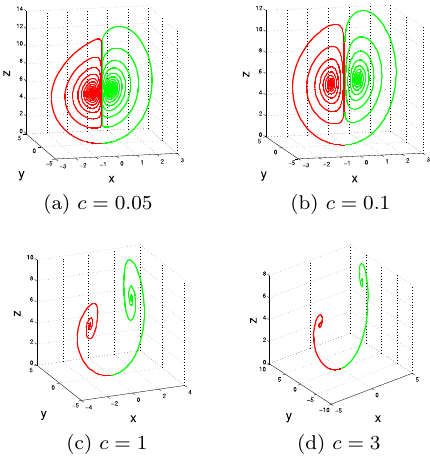
Figure 7. Two orbits of system (1.3) for the parameters ( a,b ) = (1 , 6) and c varies satisfying c > 0, the initial conditions ( x 0 ,y 0 ,z 0 ) = ( ± 3 . 82 × 1 e − 5 , ± 6 . 18 × 1 e − 5 , 0) and time integration: [0 , 750]. These figures display the existence of two heteroclinic orbits of system (1.3) joining E 0 and E ±